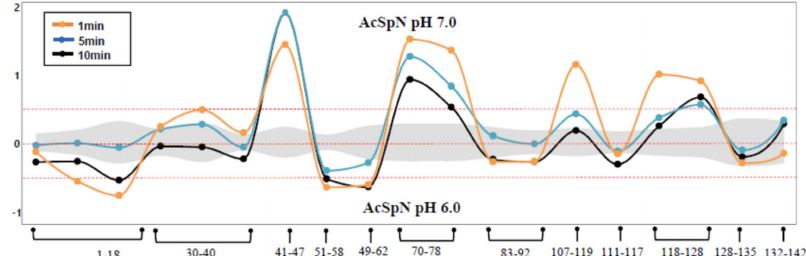
Figure 5. Di ff erences in average deuterons exchanged ( Y -axis) in AcSpN at pH 7.0 and pH 6.0 for three di ff erent exchange times. Each pepsin proteolyzed peptide is listed from N to C terminus ( X -axis). Peptides spanning continuous regions are grouped by brace brackets. Empirically determined 0.5 Da di ff erence in deuterium uptake is considered as significant (dashed lines). Positive and negative di ff erences in deuterium exchange represent increased and decreased exchange, respectively, in the AcSpN from pH 6.0 to pH 7.0 by the respective peptides. Standard deviations are shaded gray. Orange, blue, and black dots and lines represent exposure times of 1, 5, and 10 min at pH 7.0 and 10, 50, and 100 min at pH